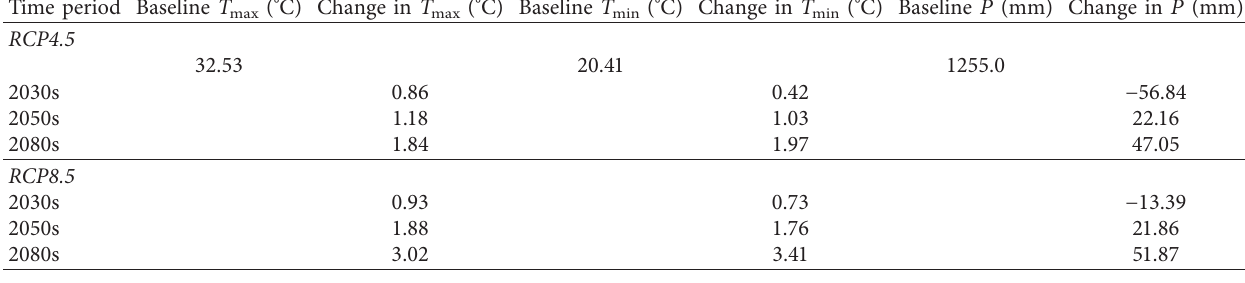
max ), minimum temperature ( T min ), and precipitation (